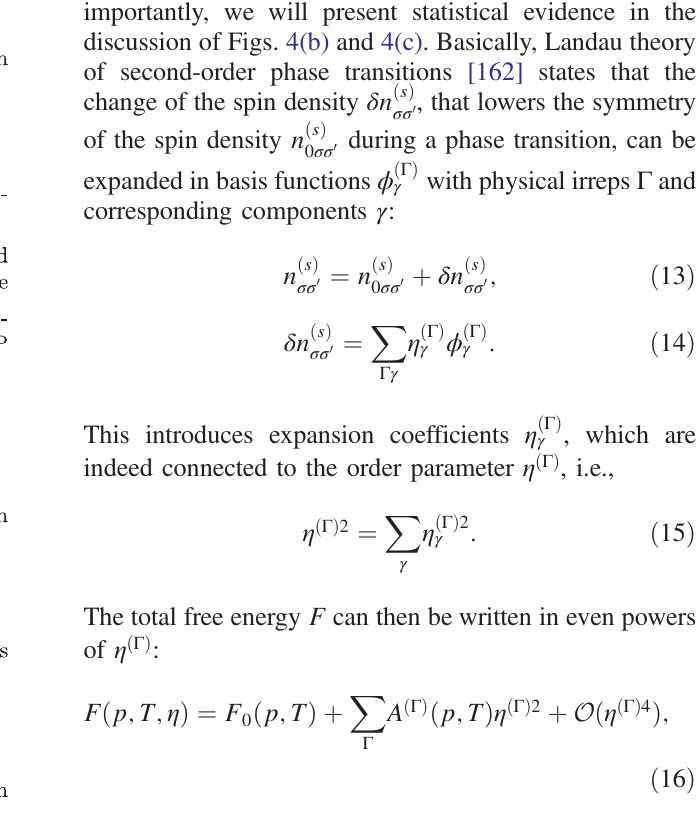
FIG. 2. Computational workflow divided into four steps: input, setup, calculation, and